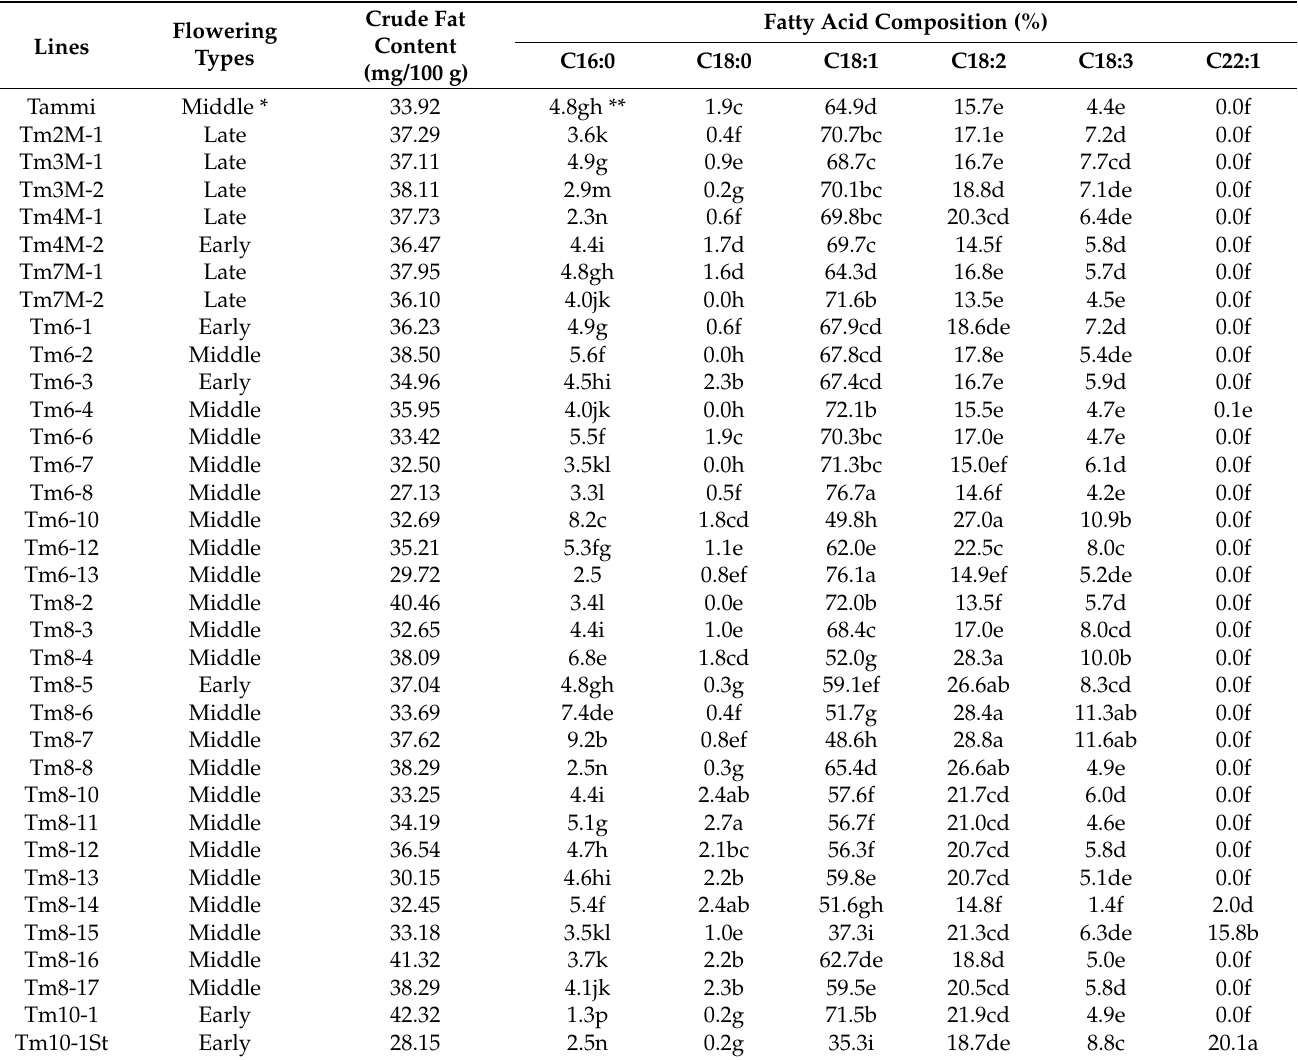
Table 1. Flowering time, crude fat content, and fatty acid compositions of rapeseed mutant used in this